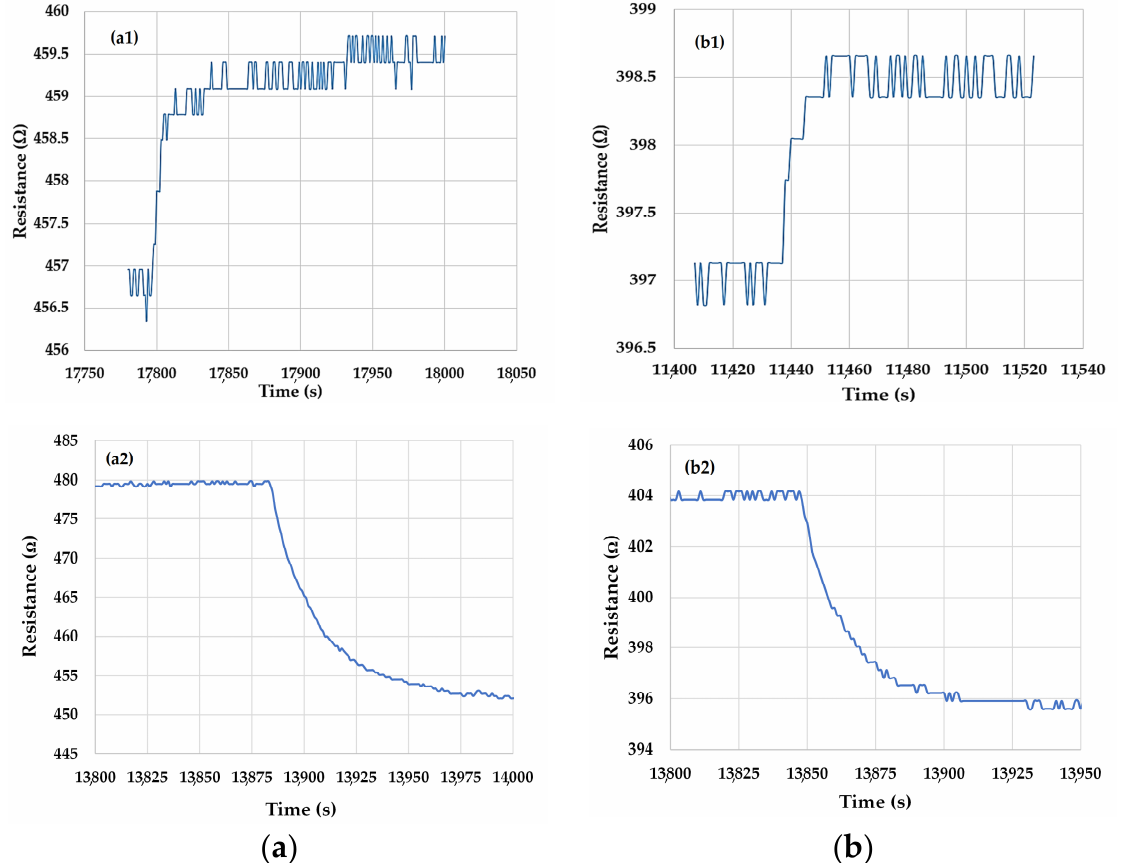
Figure 5. Response and the recovery times of the chemiresistive ethanol sensors with sensing films kept at room temperature and consisting of ( a ) ox-SWCNH / SnO 2 / PVP = 1 / 1 / 1 (mass ratio), where ( a1 ) is response time, and ( a2 ) is recovery time and ( b ) ox-SWCNH / SnO 2 / PVP = 2 / 1 / 1 (mass ratio), where ( b1 ) is response time, and ( b2 ) is recovery time. Response time was measured for a change in ethanol vapor concentration from 2 to 5 mg / L, while the recovery time was measured for a change in ethanol vapor concentration from 25 mg / L to 0 mg / L. For both cases, the flow rate of air passing through liquid ethanol was varied, while the total flow rate in the test chamber was kept constant at 1 L /